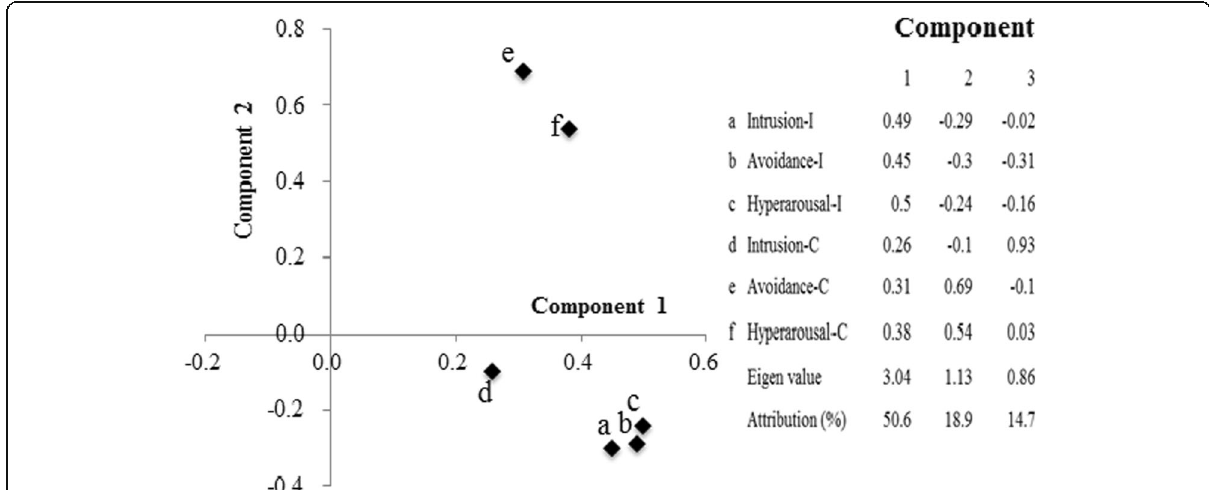
Fig. 1 The principal component analysis of Intrusion-I, Avoidance-I, Hyperarousal-I, Intrusion-C, Avoidance-C, and Hyperarousal-C. a Comparison of components 1 and 2. b Values of components 1 – 3 . Statistically significant eigenvectors are indicated in bold ( P <